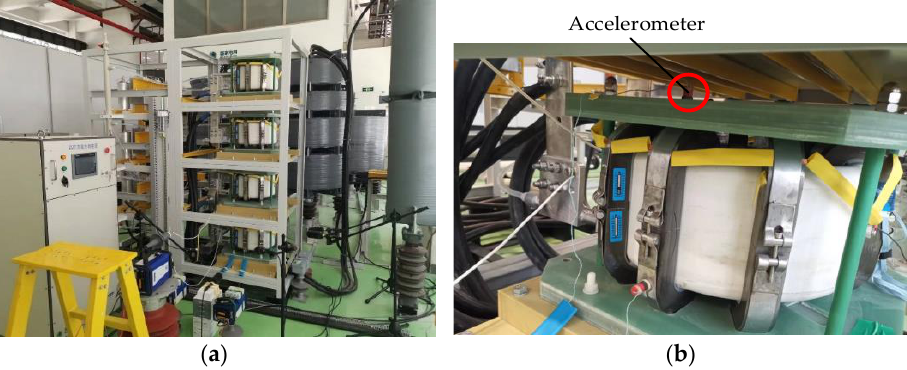
Figure 7. Saturable reactor vibration experiment: ( a ) experimental field; ( b ) saturable reactor appearance and installation of the accelerometer. Table 4. Parameters of the vibration experiment.